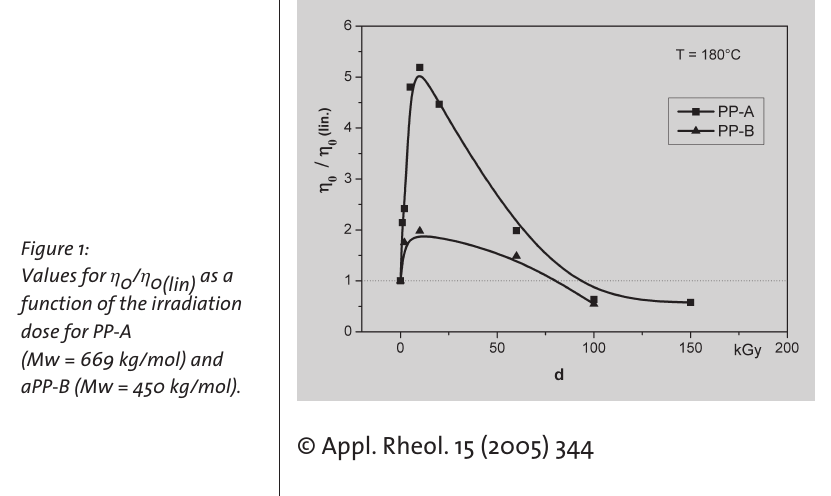
Figure 1: Values for h 0/ h 0(lin) as a function of the irradiation dose for PP-A (Mw = 669 kg/mol) and aPP-B (Mw = 450